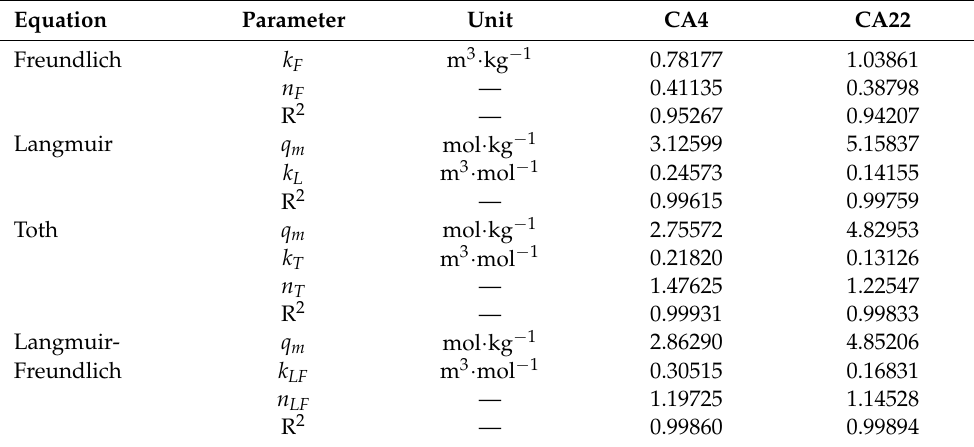
Table 2. Adsorption isotherm parameters for Pt(cod)me 2 from scCO 2 solution at 27.7 MPa and 353 K on different substrates